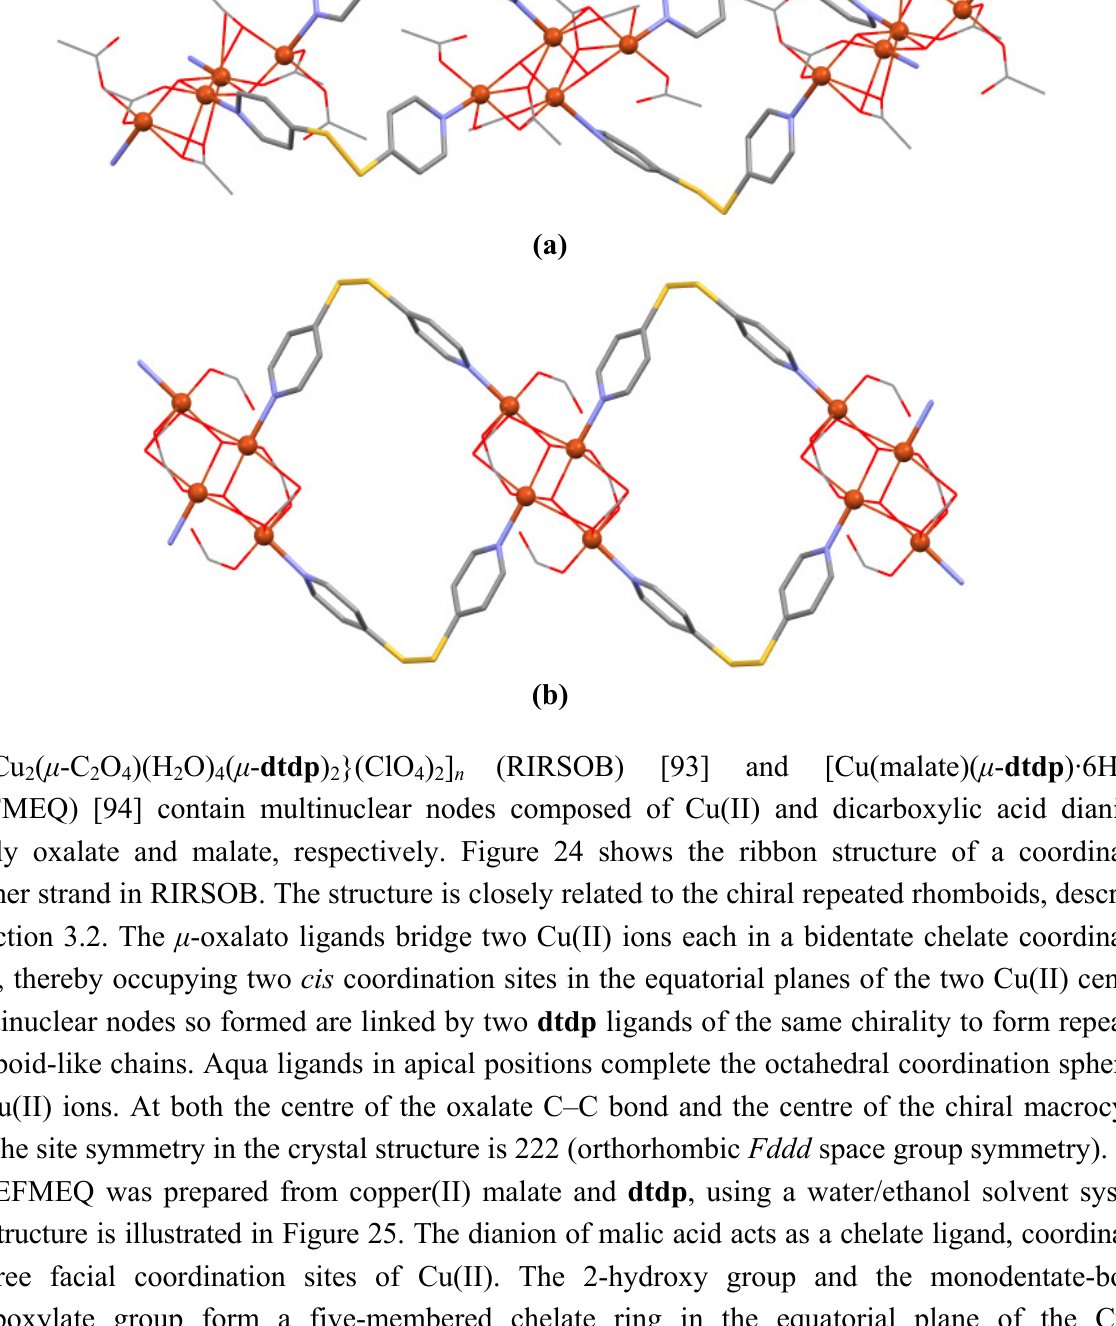
Figure 23. Repeated rhomboid related coordination polymer strands based on tetranuclear basic copper(II) carboxylate nodes in ( a ) [Cu